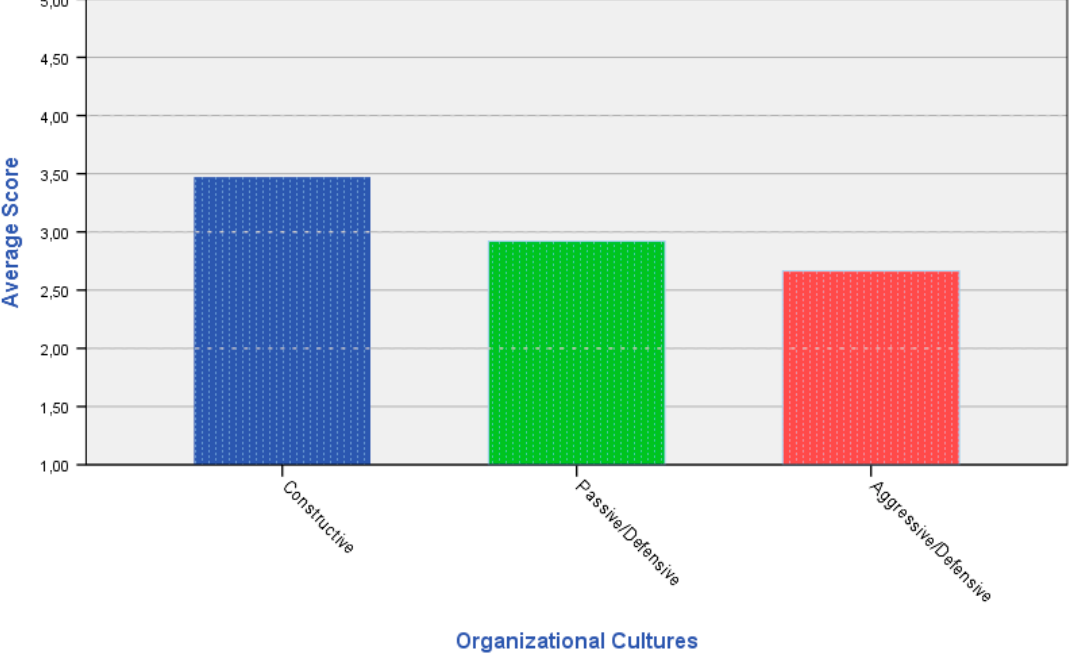
Figure 2. OCI Organizational culture averages.